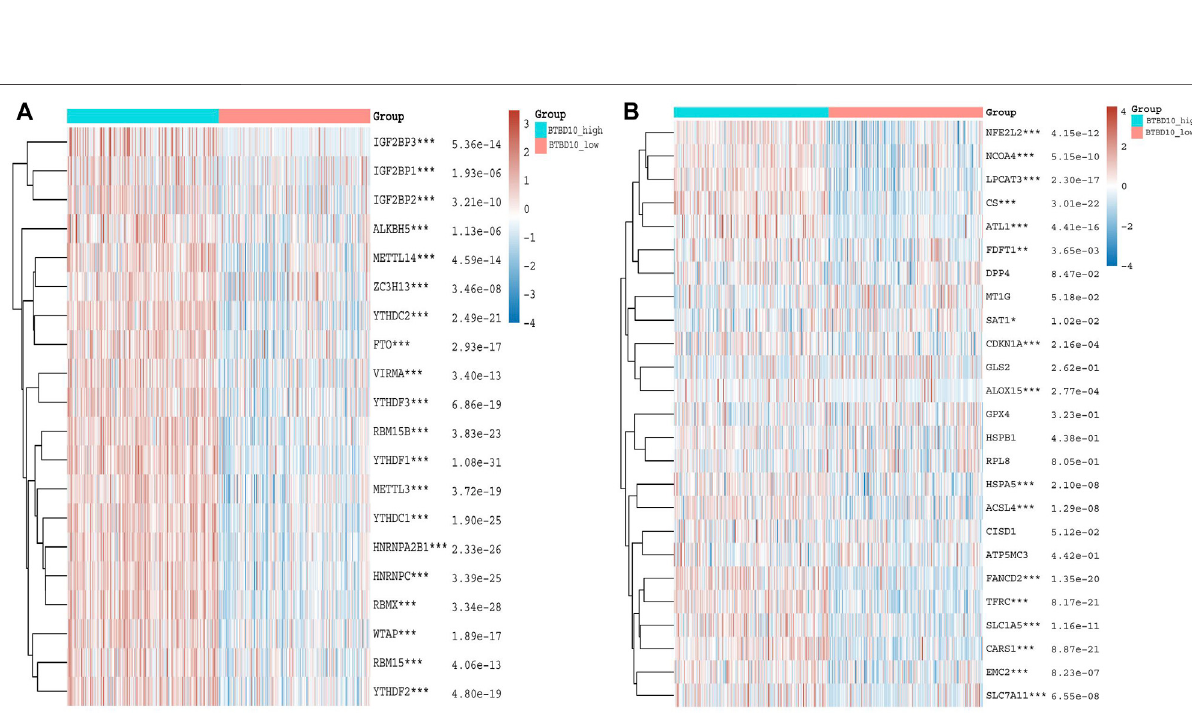
Frontiers in Molecular Biosciences |